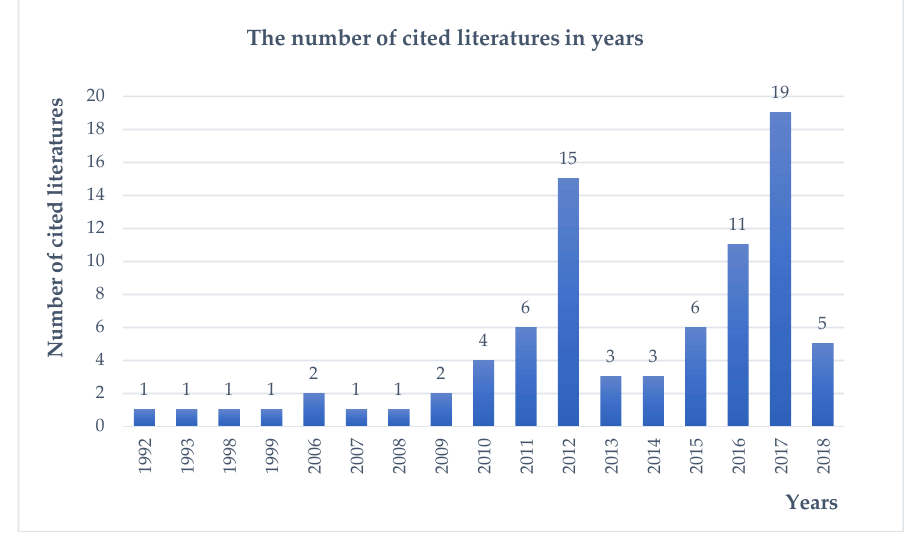
Figure 3. The number of cited literature sources in target years (Data collection from cited literatures— Figure edited by authors).